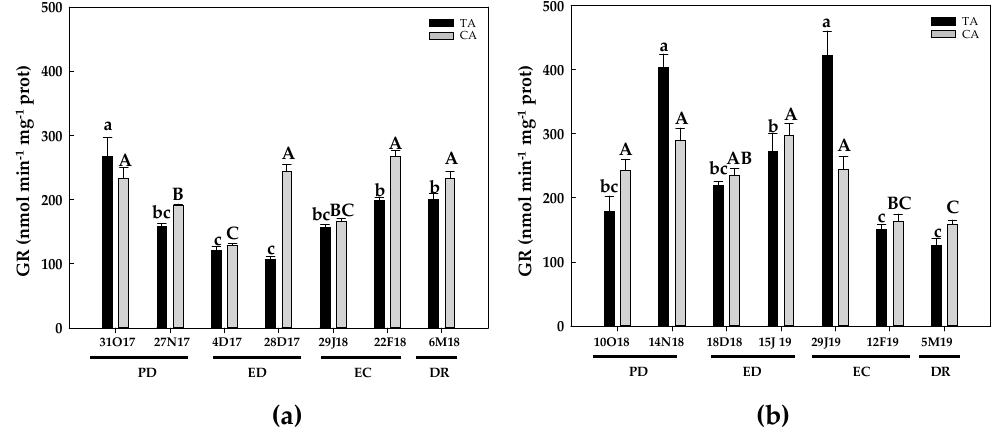
Figure 10. Evolution of glutathione reductase (GR) activity in flower buds of peach ‘GEM020’ cultivated in two different geographical areas during the dormancy cycle on two seasons. ( a ): season 1 (2017–2018); ( b ): season 2 (2018–2019). Data represent the mean ± SE, n = 5. Different letters (lowercase and uppercase for the samples of the temperate (TA) and the cold area (CA), respectively) indicate significant differences according to Tukey’s multiple test ( p ≤ 0.05). PD: paradormancy; ED: endodormancy; EC: ecodormancy; DR: dormancy release. FW: fresh weight. The chill units accumulated at the different times and locations are shown in Supplemental file 1.